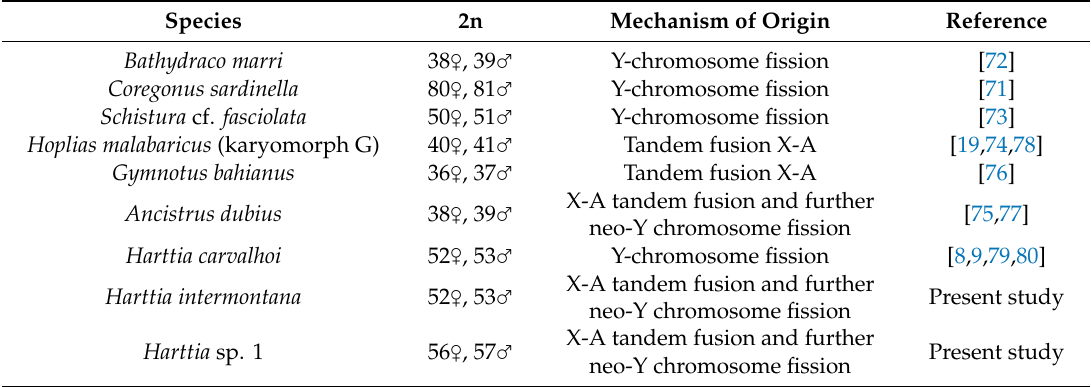
Table 3. Multiple XX / XY 1 Y 2 sex chromosome systems currently found in